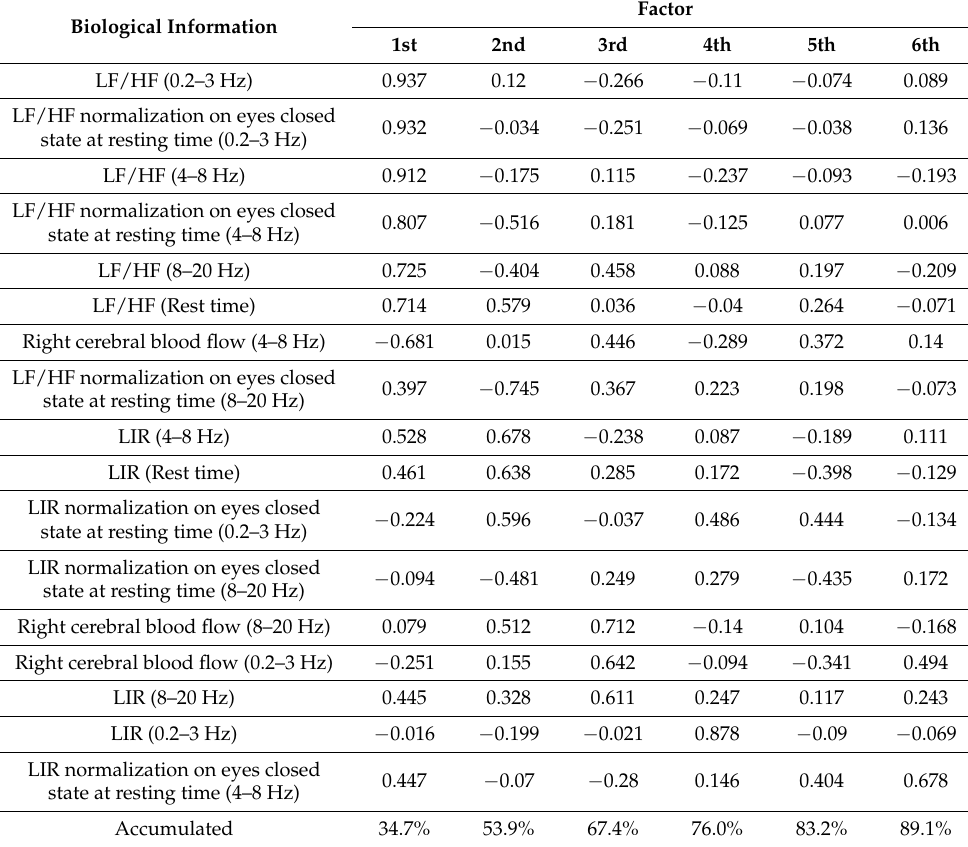
Table 2. Results of principal component